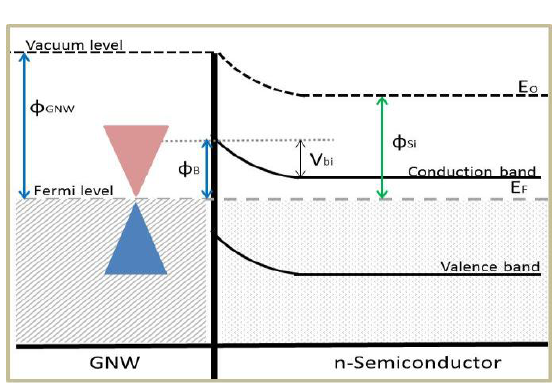
Figure 4. Energy band diagram of graphene on n-type silicon junction.